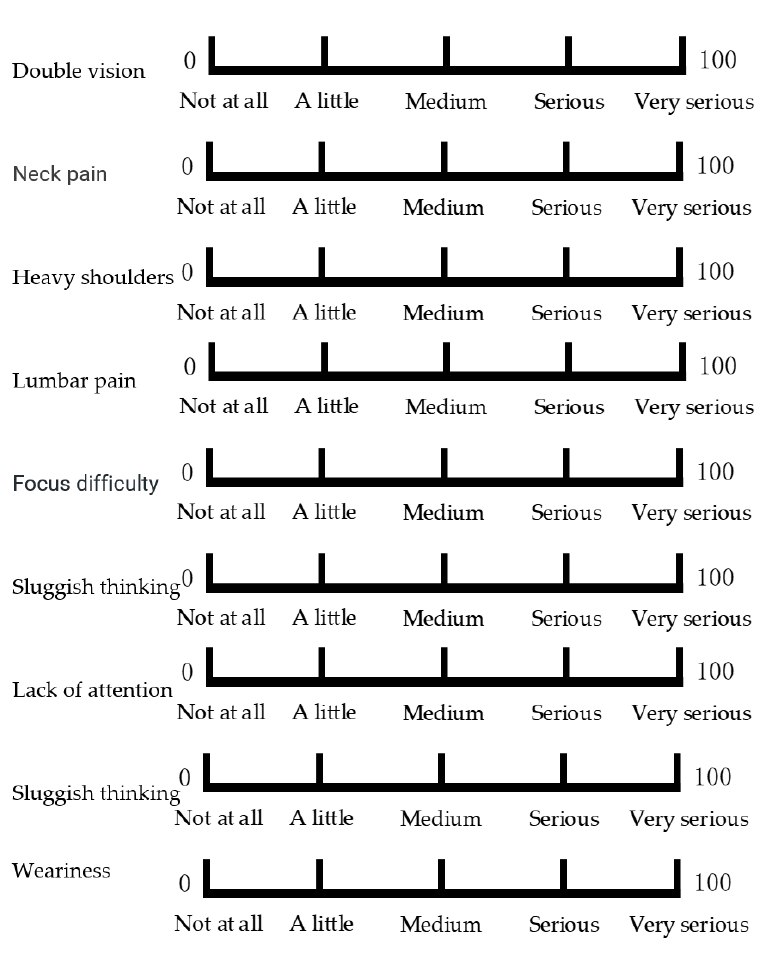
Figure 5. Display terminal visual fatigue test and evaluation method part 2 scale evaluation method [13].